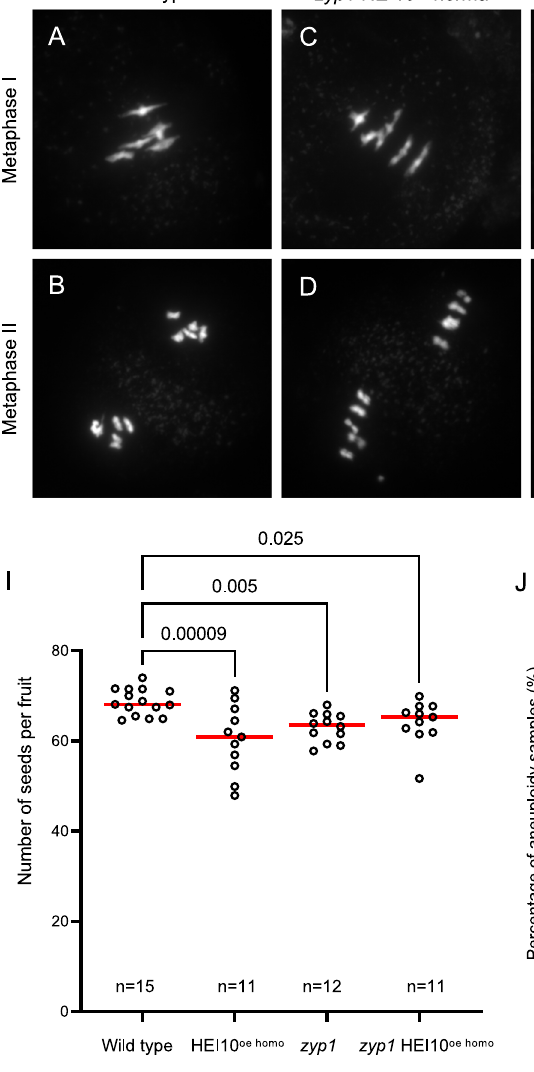
Fig. 3 | Analysis of meiotic and fertility defects. A – F DAPI-stained meiotic chro- mosome spreads from Col/L er male meiocytes in wild type ( A , B ) and zyp1 HEI10 oe ( C – F ). A , C , E Metaphase I. B , D , F Metaphase II. C , D Normal chromosome con- fi gurations in zyp1 HEI10 oe . E , F Rare abnormal chromosome con fi gurations in zyp1 HEI10 oe . Scale bar=10 µ m. G , H Representative cleared fruits of wild type Col and zyp1 HEI10 oe mutants. I Corresponding quanti fi cation of fertility. Each dot repre- sentsthefertilityofanindividualplant,measuredasthenumberofseedsperfruits